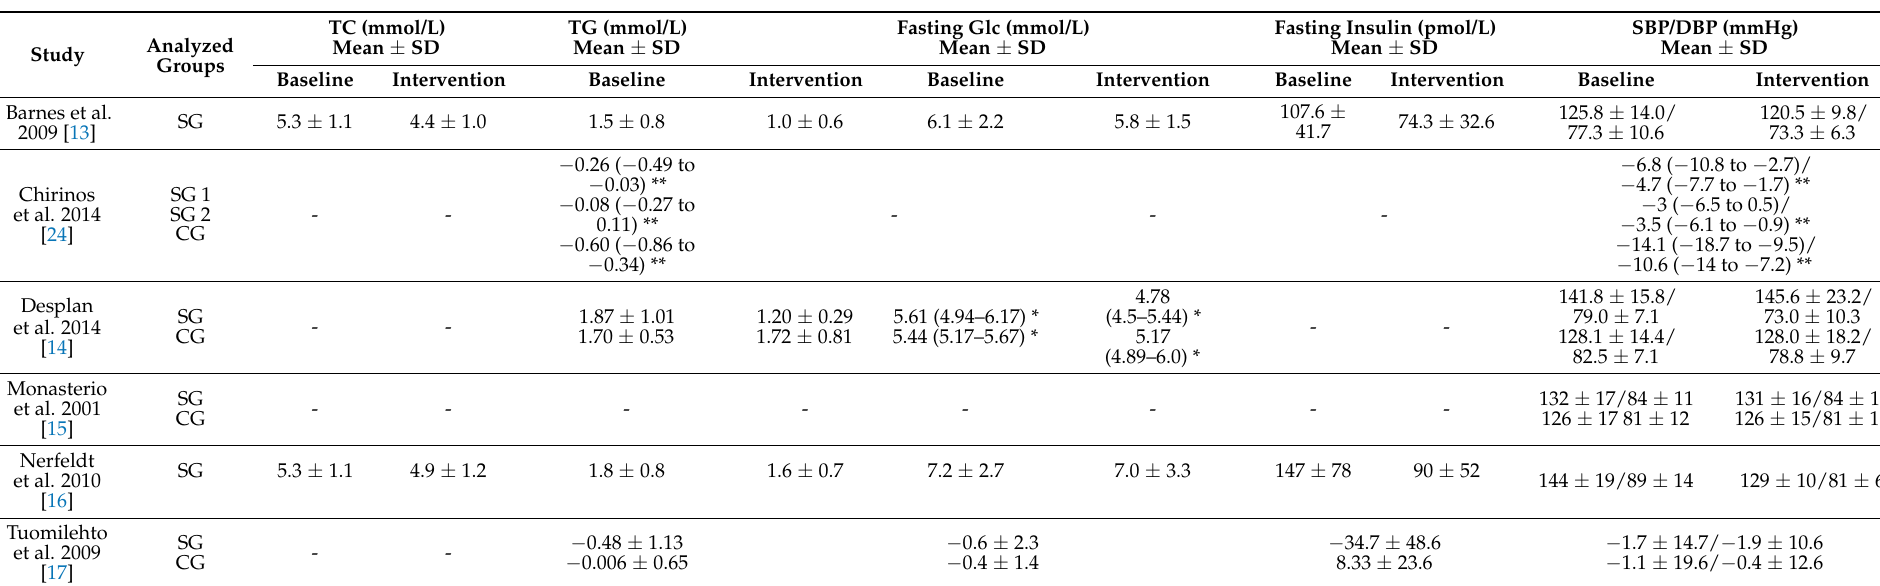
Table 2. Mean changes in cardio-metabolic risk factors during dietary intervention in the study and control groups in selected